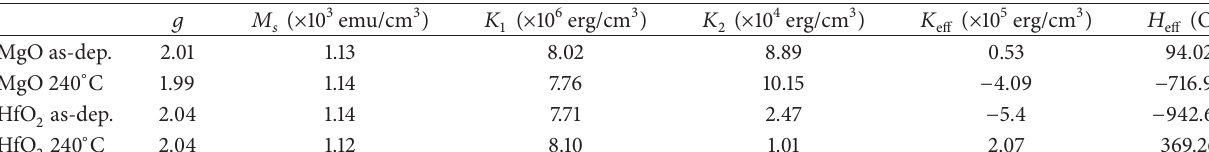
Table 1: Fitting parameters deduced from (1) in the four samples.